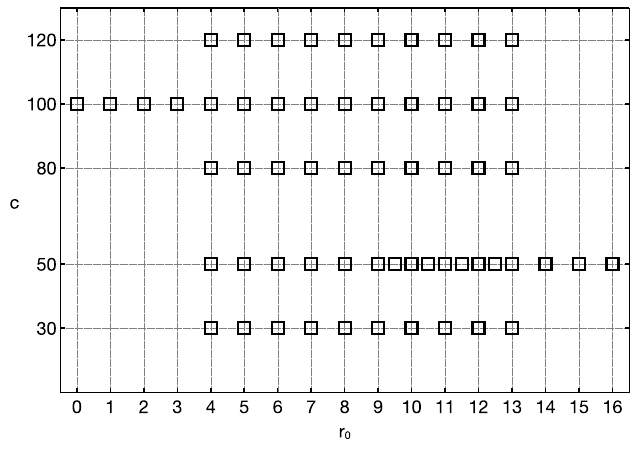
Figure 8 . Map of the c values used at each r 0 distance for N = 8, L = 8 and T = 3 : 0. The distance where the force becomes negative is r 0 2 [9 ;